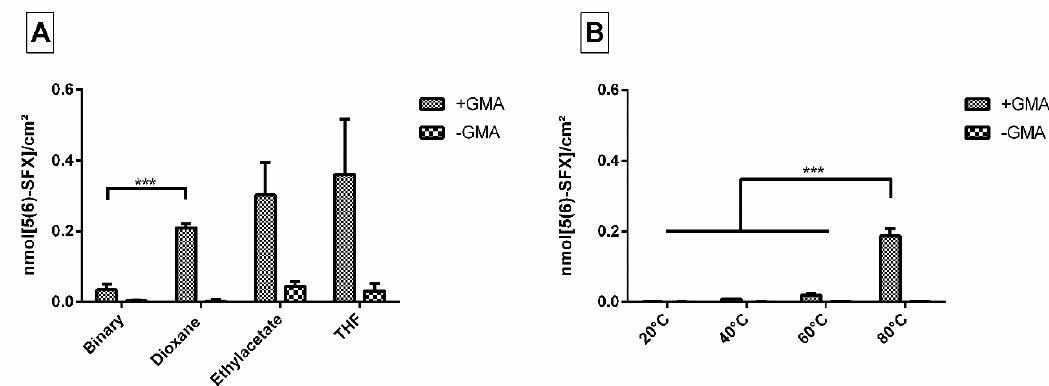
Figure 1. ( A ) Immobilized 5(6)-SFX indicating the amount of accessible, derivatizable amino groups introduced to the film surface via ED900 linker addition after cross-copolymerization with and without GMA using di ff erent solvents. Binary solvent mixture consisted of acetone and DCM (5:3). ( B ) 5(6)-SFX bound to film surfaces with and without GMA after incubation at di ff erent temperatures. The applied cross-copolymerization solvent is dioxane, short incubation periods (2 h) at 80 ◦ C were compared to longer incubation (15 h) at 20, 40, and 60 ◦ C. All values represent the mean ± SD of n ≥ 4. *** p < 0.001 vs. respective treatment.